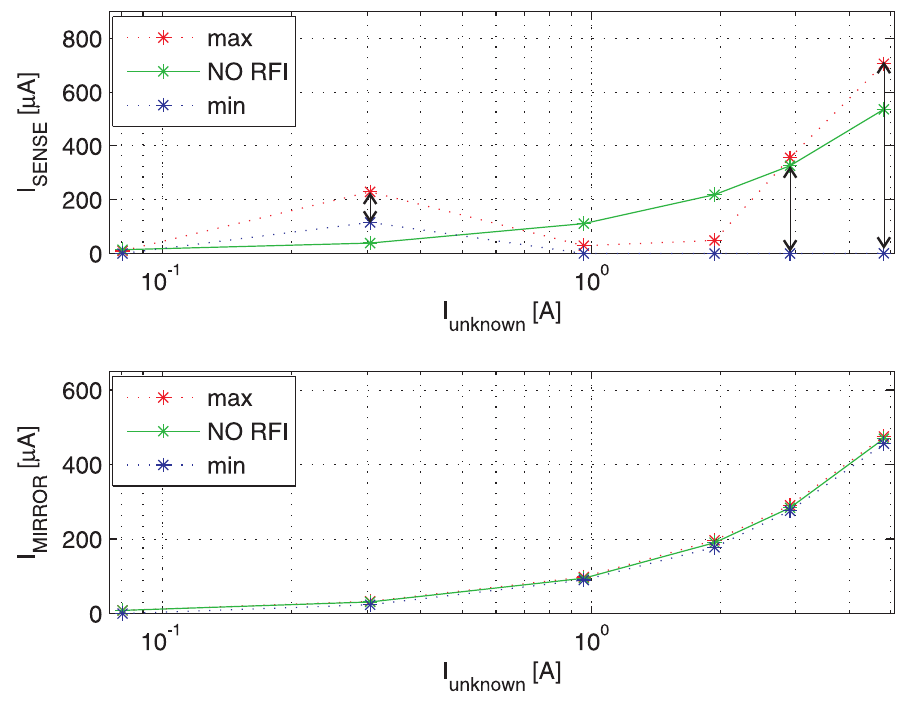
Figure 11. Maximum and minimum current-sensing of the traditional SenseFET current sensor ( I ) and the new sensor based on the Miller effect ( I SENSE sense I . CW RFI current amplitude 200 mA @ 100 MHz. D